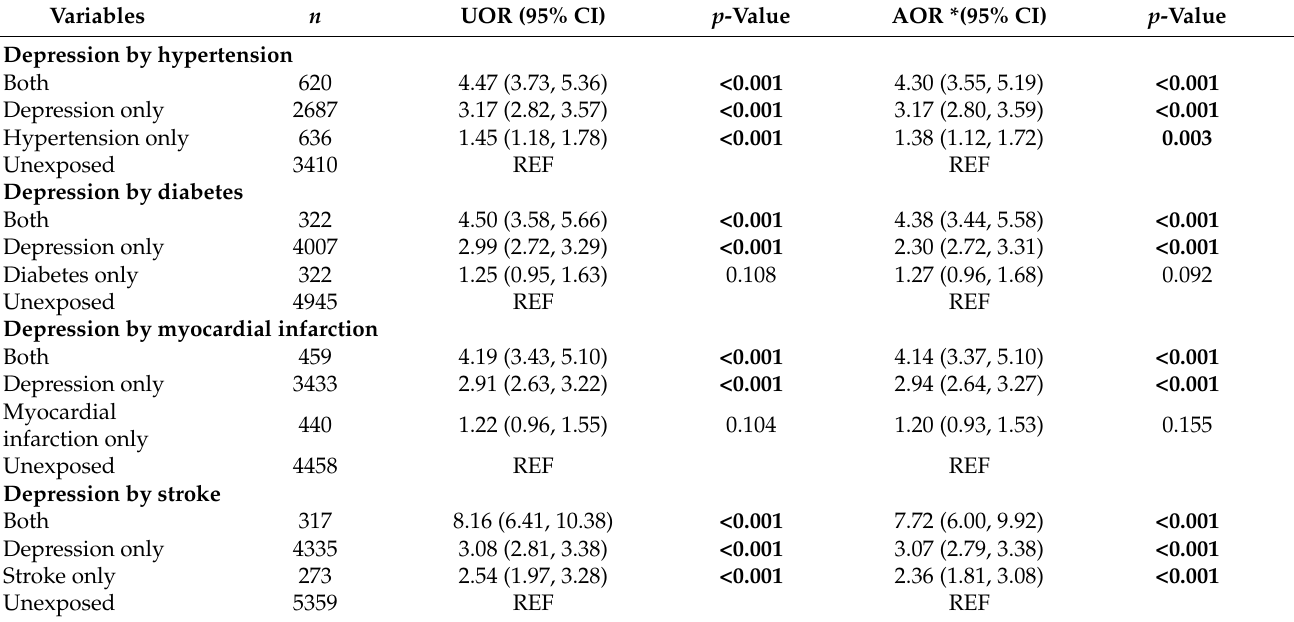
Table 6. The risk of functional impairment according to depression and comorbid vascular disease (instrumental activity of daily